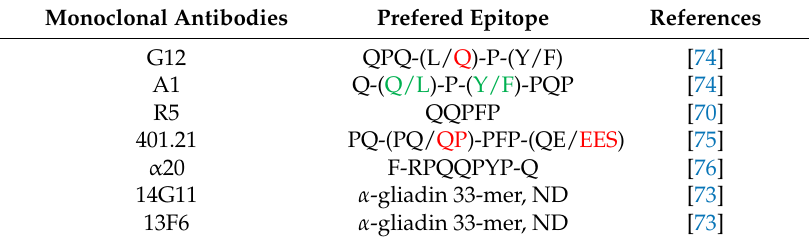
Table 2. Commercial antibodies used to detect gluten and preferably recognized cereals and epitopes. Monoclonal